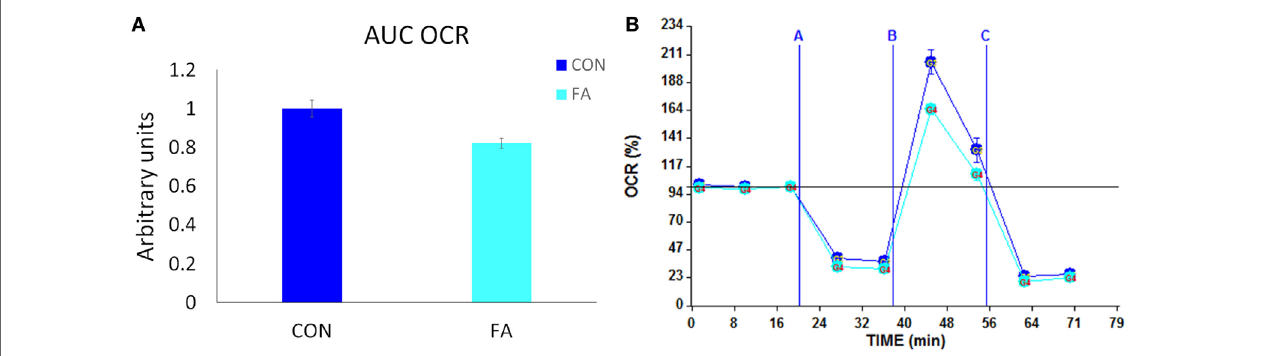
FigUre 6 | Metabolic profiling of C2C12 cells in in control (CON) and EPA/DHA (FA) medium. (a) Total oxygen consumption (reserve capacity) is significantly lower in FA group. Data show the change of oxygen consumption rates (OCR) in FA group compared with CON group. The relative change was calculated in arbitrary units. (B) Basal and stimulated mitochondrial OCR in cultured C2C12 cells. OCR traces are expressed as pmol O 2 per min in C2C12 cells and normalized to cell number. Vertical dashed lines indicate the times of addition of oligomycin (2 µM), FCCP (350 nM), and antimycin A (10 µM). * P < 0.05; n =